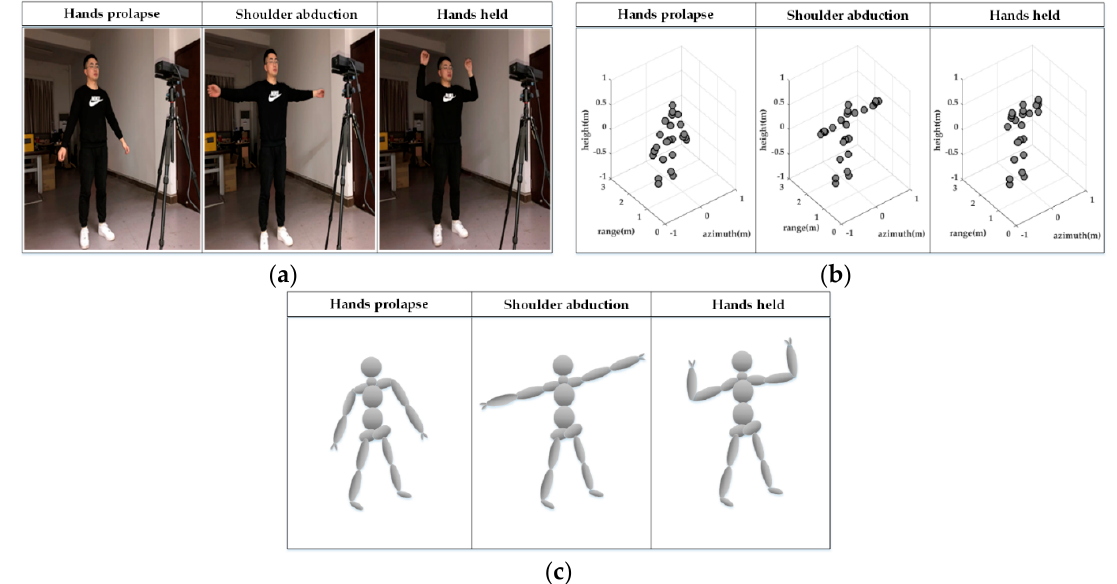
Figure 3. ( a ) Experiment scene; ( b ) The 3-D coordinates obtained by Kinect; ( c ) The human ellipsoid model.